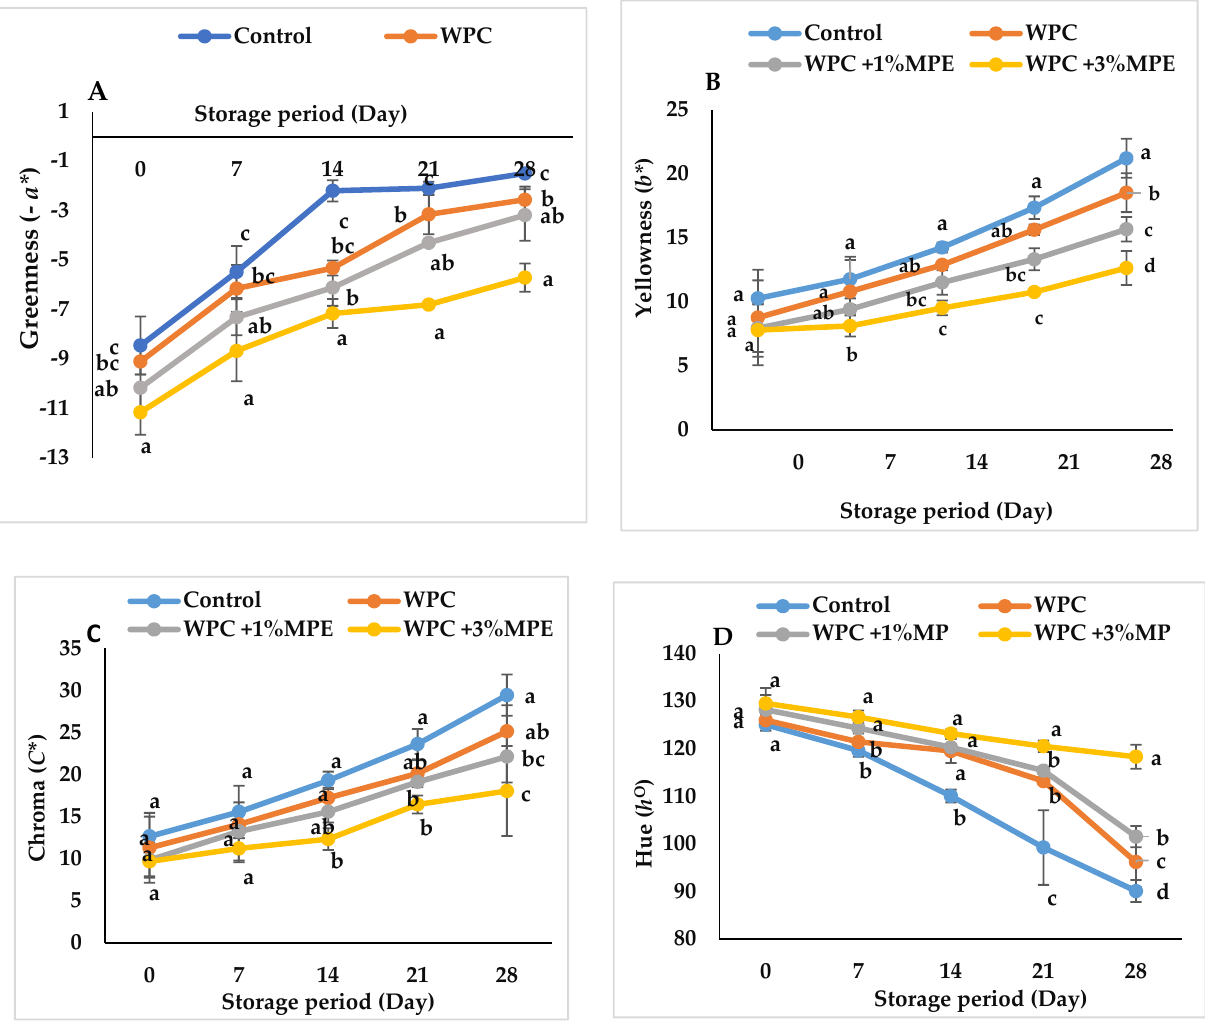
Figure 2. Effect of whey protein concentrate combined with mango peel extract (WPC = whey protein concentrate alone, WPC + 1% MPE = whey protein concentrate + mango peel extract at 1% and WPC + 3% MPE = whey protein concentrate + mango peel extract at 3%) on ( A ) greenness ( -a *), ( B ) yellowness ( b* ), ( C ) chroma ( C *), and ( D ) hue ( h o ) of broccoli fresh-cuts at 5 °C. Vertical bars indicate standard deviation (n = 6). Means and different letters indicate significant difference between treated and control broccoli for each storage period (Duncan’s multiple range test at 95%).